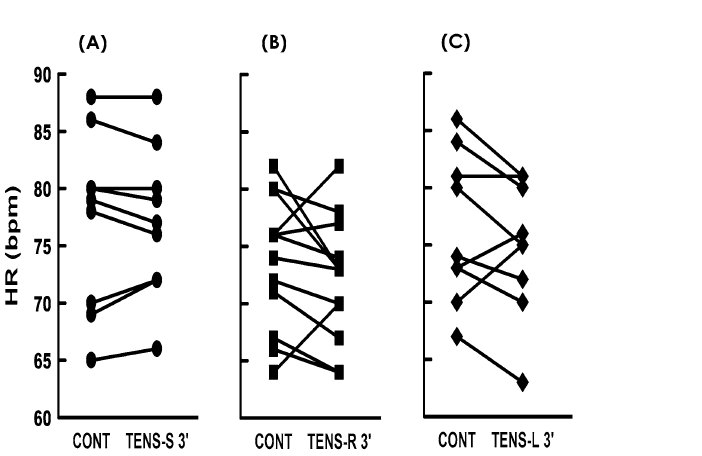
Figure 4. Individual heart rate (HR) of subjects at baseline control (CONT) and 3 min following ( A ) sham stimulation (TENS-S 3’) and ( B , C ) TENS at the right and left shoulder (TENS-R 3’ and TENS-L 3’, respectively). Mean HR of CONT and TENS-S/R/L 3’: ( A ) 77.30 ± 2.31 and 77.00 ± 1.98, ( B ) 73.84 ± 1.55 and 72.23 ± 1.49, and ( C ) 76.44 ± 2.18 and 74.77 ± 1.95 bpm,